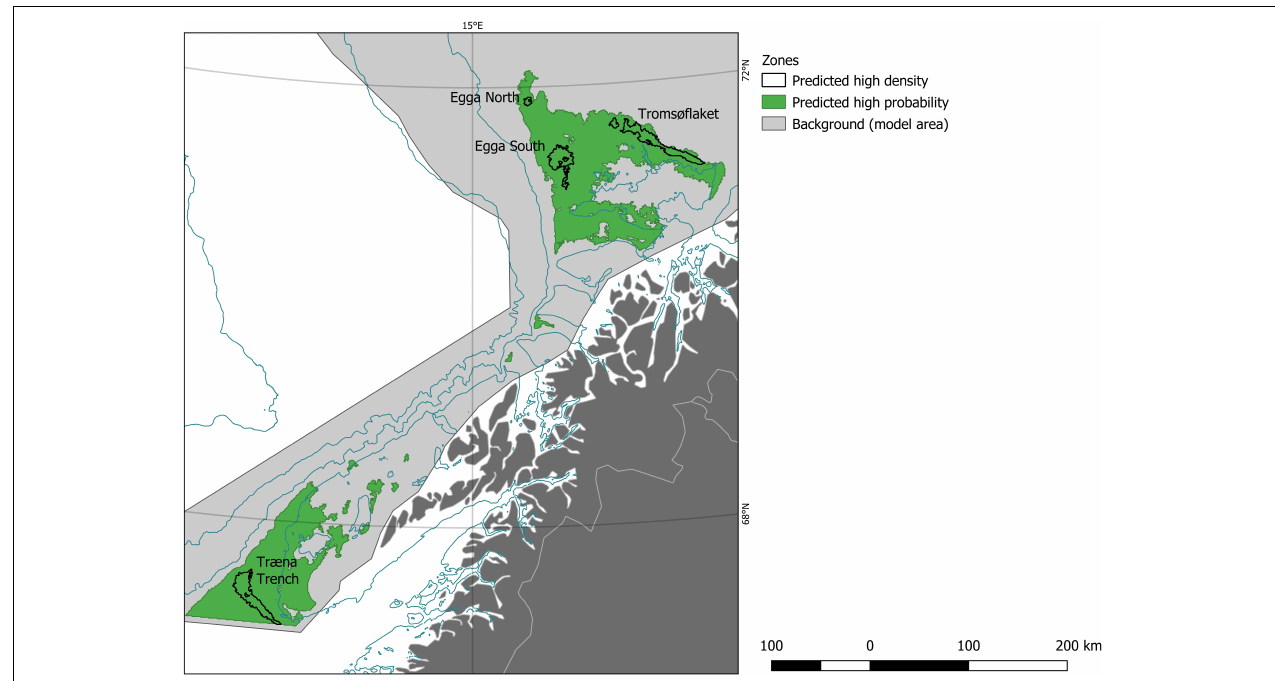
FIGURE 4 | The areas referred to as “predicted high probability” are those where the model predicted a probability of presence of soft-bottom, deep-sea sponges larger than 0.75 (green), whereas the areas referred to as “predicted high density” enclose the pixels where the model predicted a density of the target species above 13 colonies/100 m 2 (outlined in black). For reference we have also plotted the extent of the model area (light gray). Also shown are selected bathymetric contour lines (dark blue) and land masses with political boundaries (gray), about which more details can be found in Figure 1 . Here, we can identify four main high-density patches, or hotspots